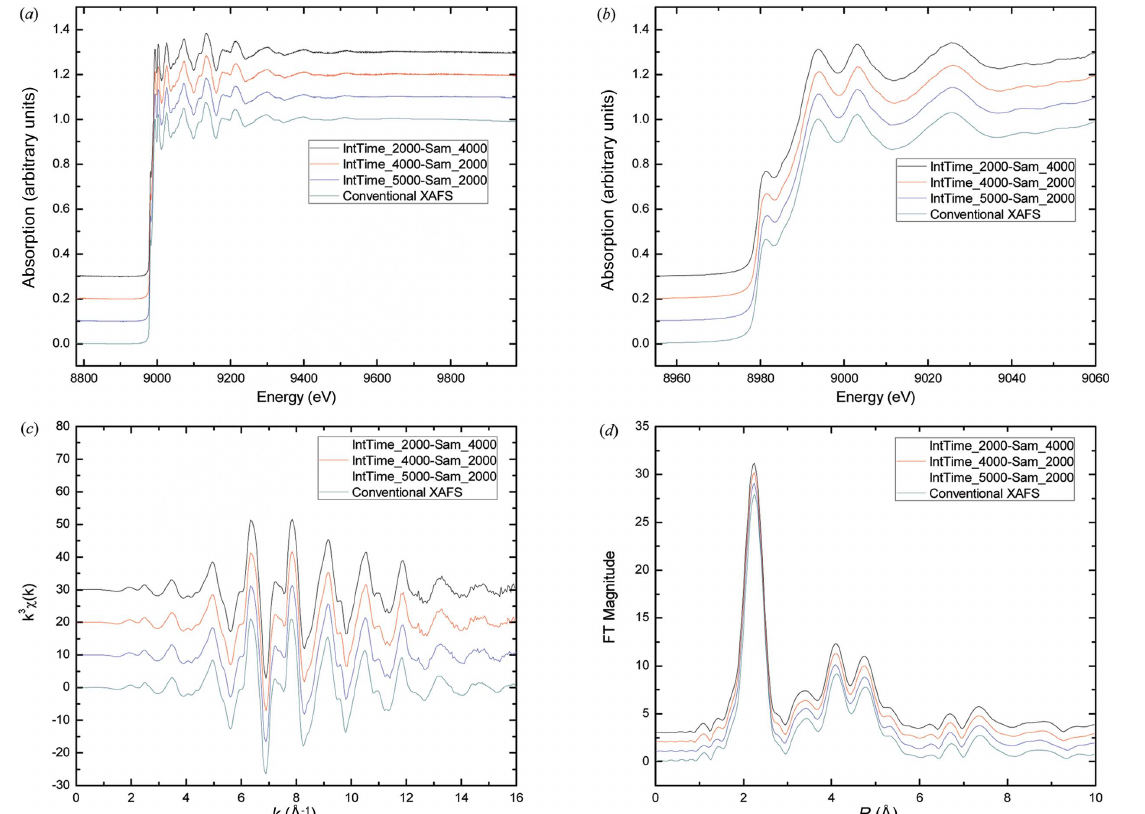
Figure 8 Comparison of the Cu K -edge XAFS spectra with a 1200 eV energy range measured by the QEXAFS system with different integration times and the conventional XAFS system. ( a ) Normalized XAFS spectra, ( b ) near-edge part, ( c ) k -space spectra, ( d ) R -space